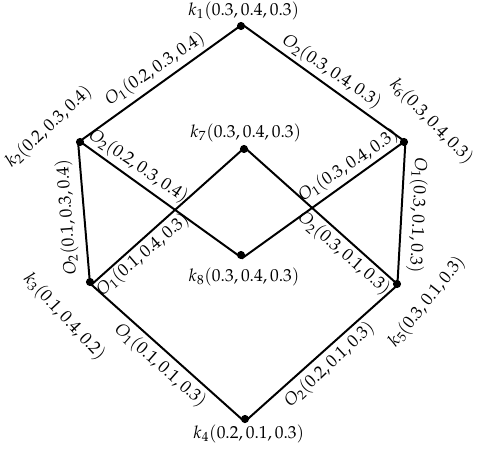
Figure 1. An intuitionistic neutrosophic graph